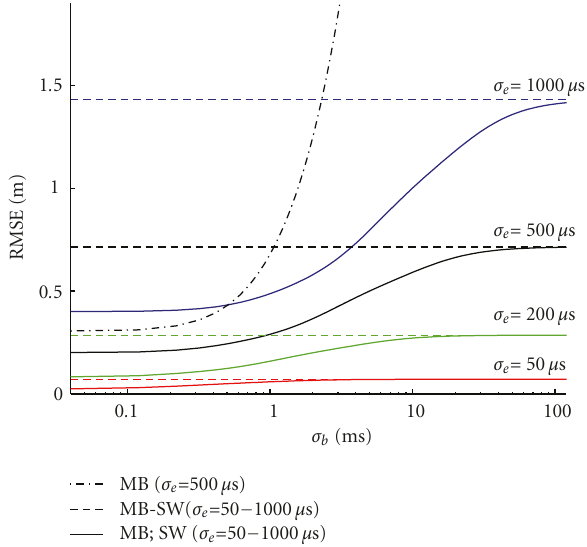
Figure 5: Cram´er-Rao RMSE bound (34) for the MB (40), the MB- SW (42), and the MB;SW models, respectively, as a function of the synchronization error (STD) σ b , and for di ff erent levels of detection error σ e .